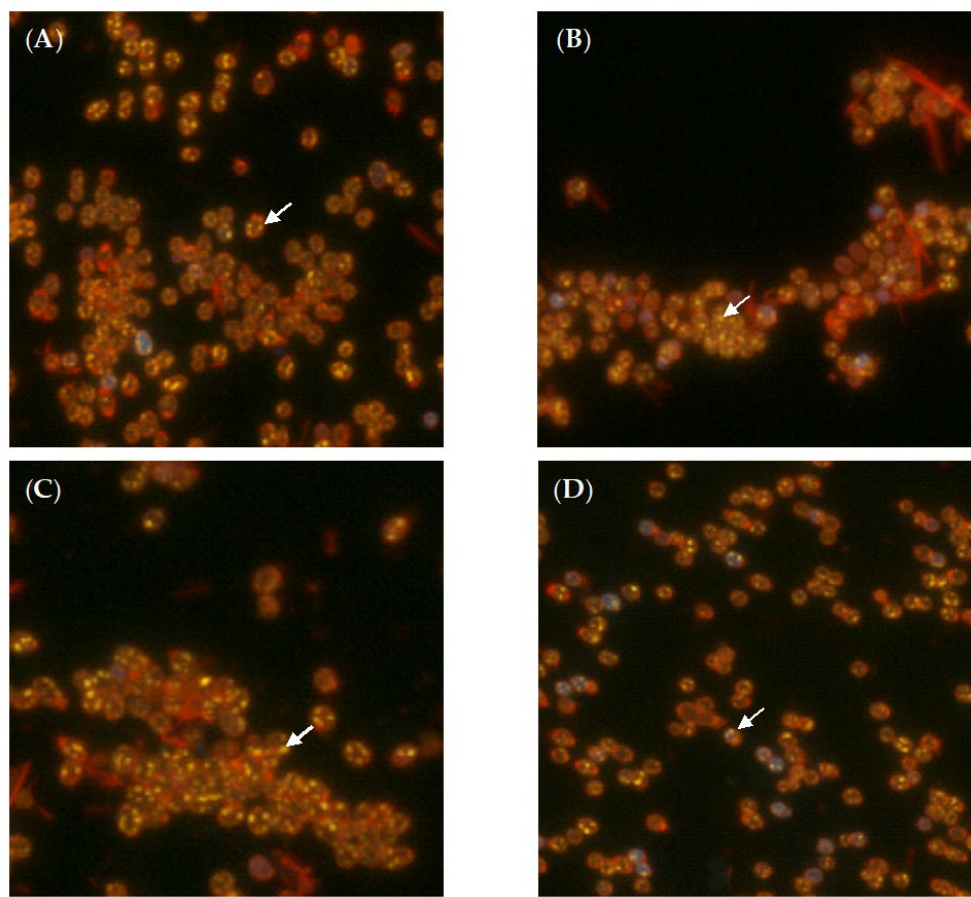
Figure 3. Fluorescent microscopy (1000 × ) of R . rhodochrous IEGM 1362 cells stained with Nile Red: ( A )—biotic control, ( B )—in the presence of (–)-isopulegol, ( C )—HNTs, ( D )—(–)-isopulegol and HNTs. Arrows indicate lipid inclusions.